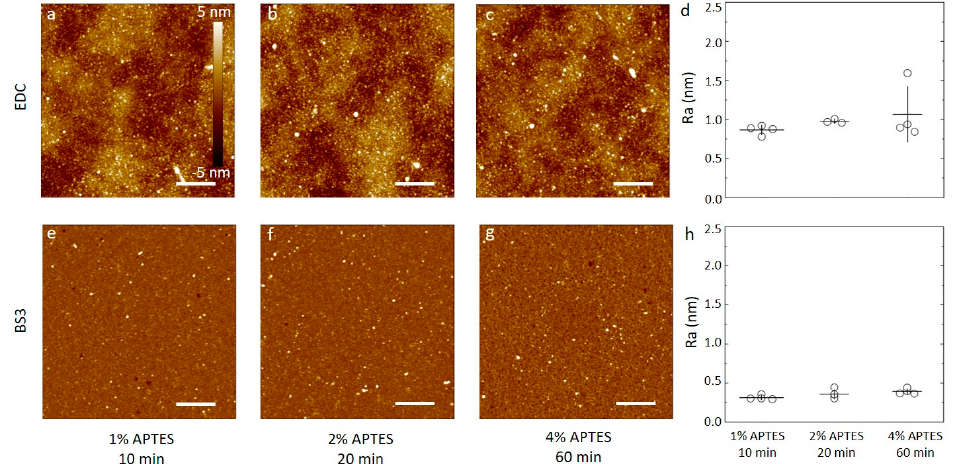
Figure 4. ( a – c , e – f ) AFM height topographs of anti-CRP antibodies immobilized on silicon substrates silanized using APTES dissolved in 1 mM acetic acid. ( a – c ) Height topographs of anti-CRP immobilized by carbodiimide chemistry (EDC) to substrates silanized using APTES concentrations and durations of ( a ) 1% APTES, 10 min, ( b ) 2% APTES, 20 min, and ( c ) 4% APTES, 60 min. ( d ) The average surface roughness obtained from 5 µ m × 5 µ m AFM topographs (n = 4, for each condition) of anti-CRP immobilized on silanized silicon. ( e – f ) Selected AFM height topographs of anti-CRP immobilized using the BS3 linker to silicon substrates silanized using APTES concentrations and durations of ( e ) 1% APTES, 10 min, ( f ) 2% APTES, 20 min, and ( g ) 4% APTES, 60 min. ( h ) The average surface roughness obtained from 5 µ m × 5 µ m AFM topographs (n = 4, for each condition) of anti-CRP immobilized using BS3 on silanized silicon substrates). The height scalebar for all topographs are shown in Figure 4a. The lateral scalebars on the AFM topographs are 1 µ